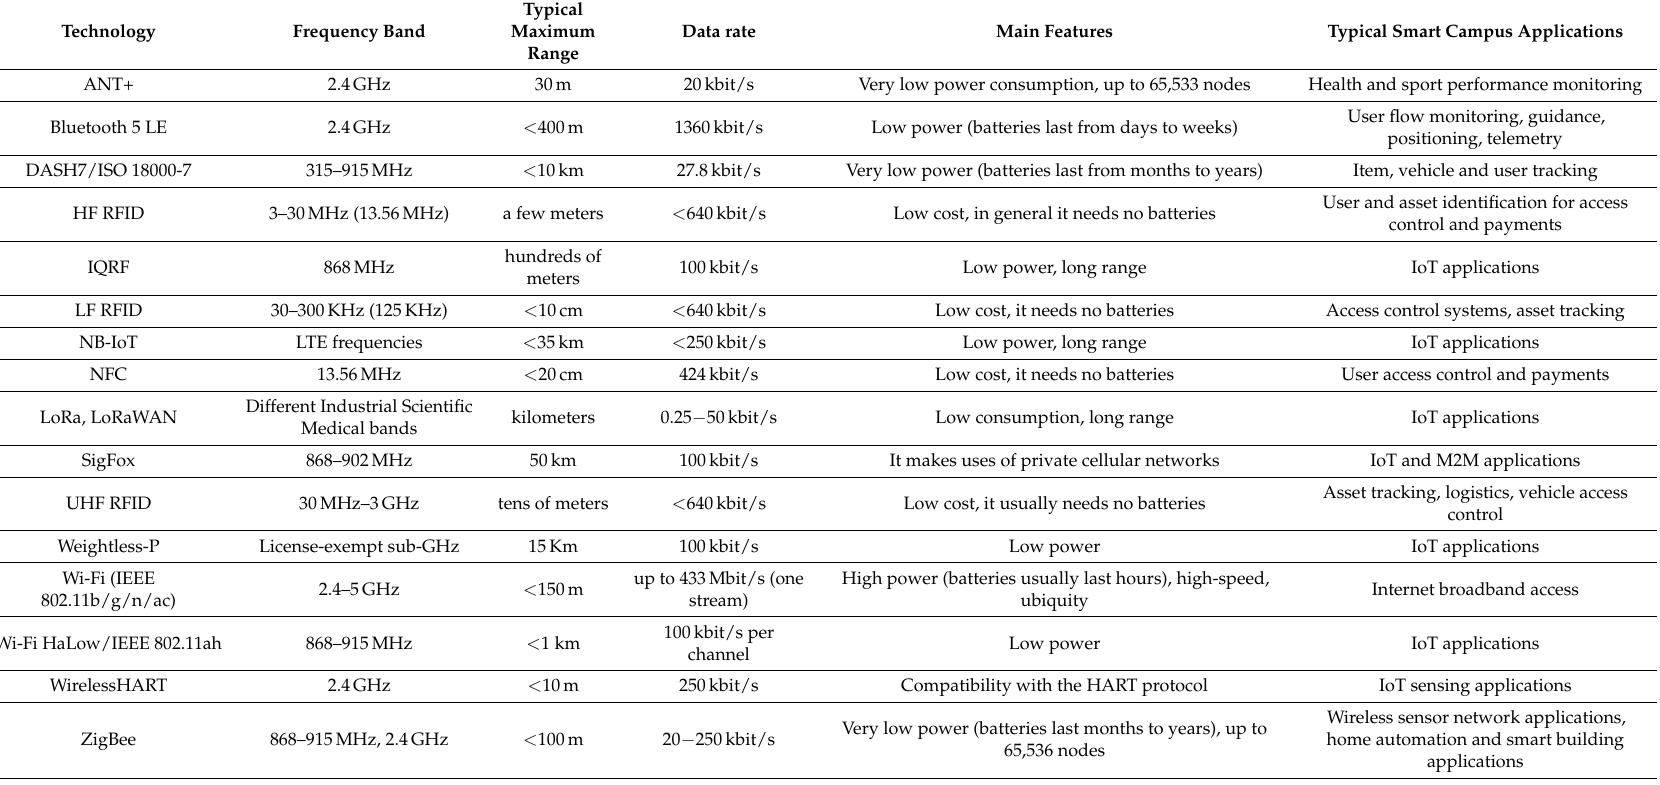
Table 2. Main characteristics of the latest and most popular communications technologies for smart campus